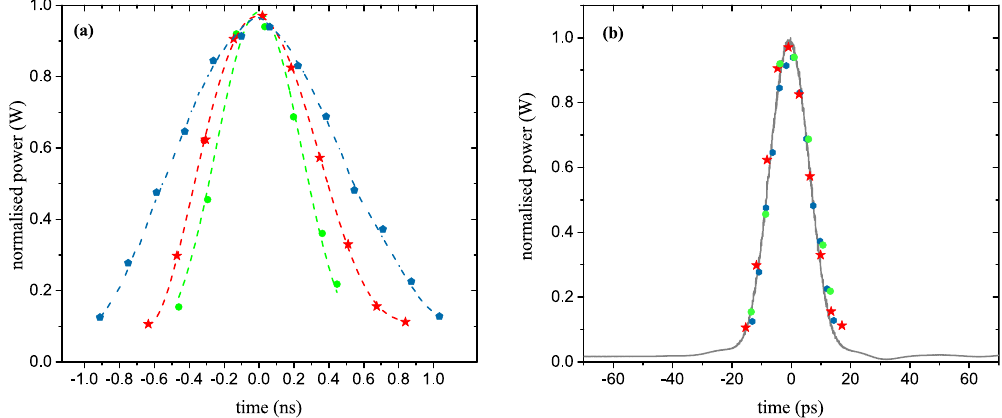
Figure 6. Stretching and sampling of the 15.55 ps input pulse with different sampling frequencies and resulting stretching factors. ( a ) By a small change of the sampling frequency Δ f S from 12.15 GHz (green) via 12.23 GHz (red) to 12.34 GHz (cyan) the stretching factor Δ S can be altered from 34 via 44 to 71. Please note that here again, the effective sampling frequency is Δ f Seff = Δ f S /2. In ( b ) the measured results of ( a ) are compressed by the corresponding stretching factor Δ S . The stars and dots correspond to ( a ). The black trace is the measured input pulse as already presented in Fig. 3(a). Evidently, the compressed pulses follow the original measurement very well.